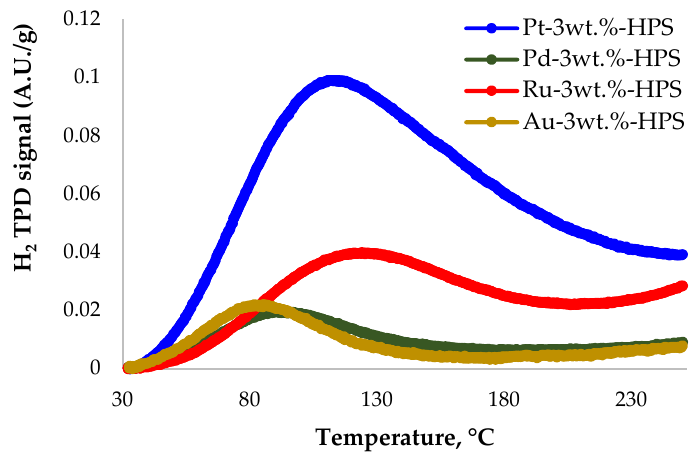
Figure 3. Results of thermogravimetric analyses of HPS MN 270. Table 3. Results of the studies of synthesized catalysts using H 2 chemisorption.